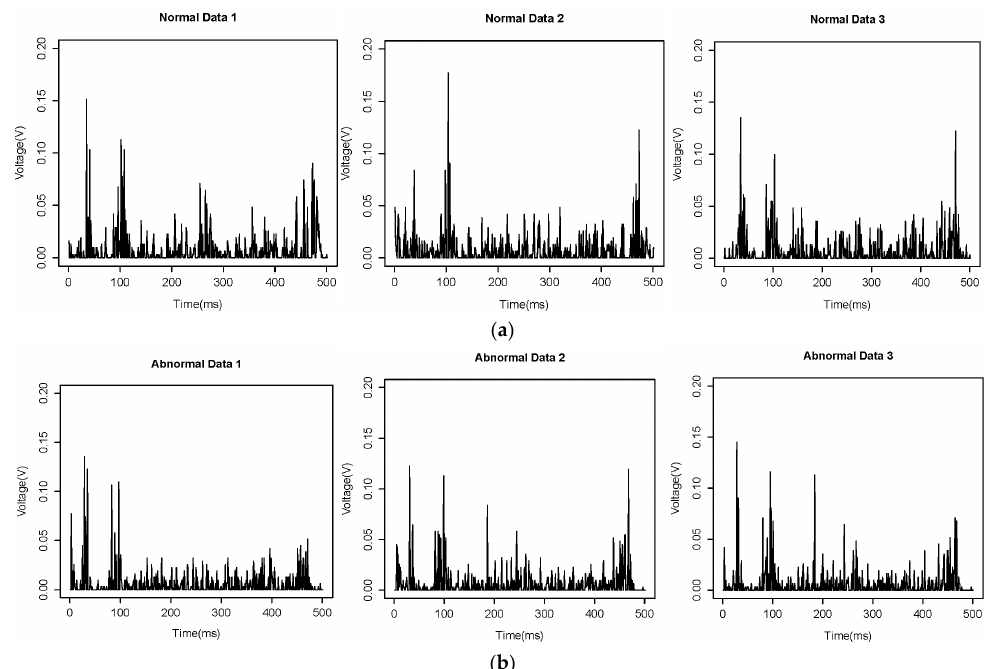
Figure 5. Vibration sensor: ( a ) normal state; ( b ) fault state.